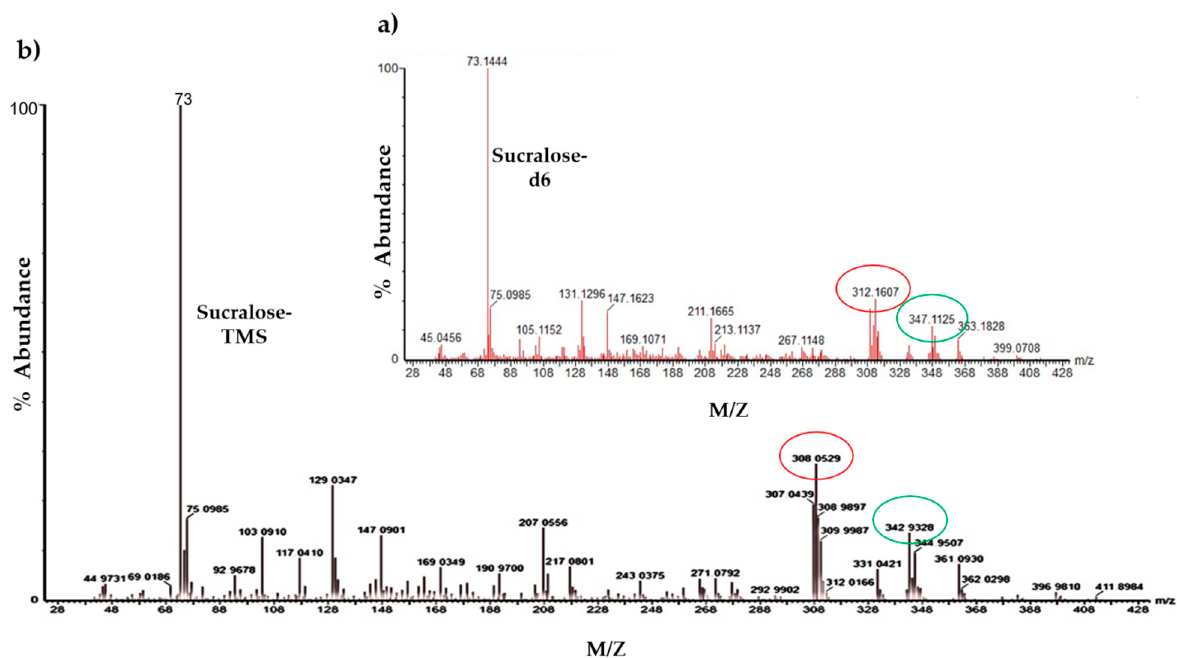
Figure 5. Mass spectra for derivatised/silylated ( a ) sucralose-d6 and ( b ) sucralose. The mass spectrum (mass/charge) for the internal standard, sucralose-d6 (panel a ), and sucralose-TMS (panel b ). The base ions of both mass spectra (circled red) are m / z 312 for internal standard and m / z 308 for sucralose-TMS. The qualifier ions (circled green) are m / z 347 for the internal standard and m / z 343 for sucralose-TMS following GC–MS analysis.